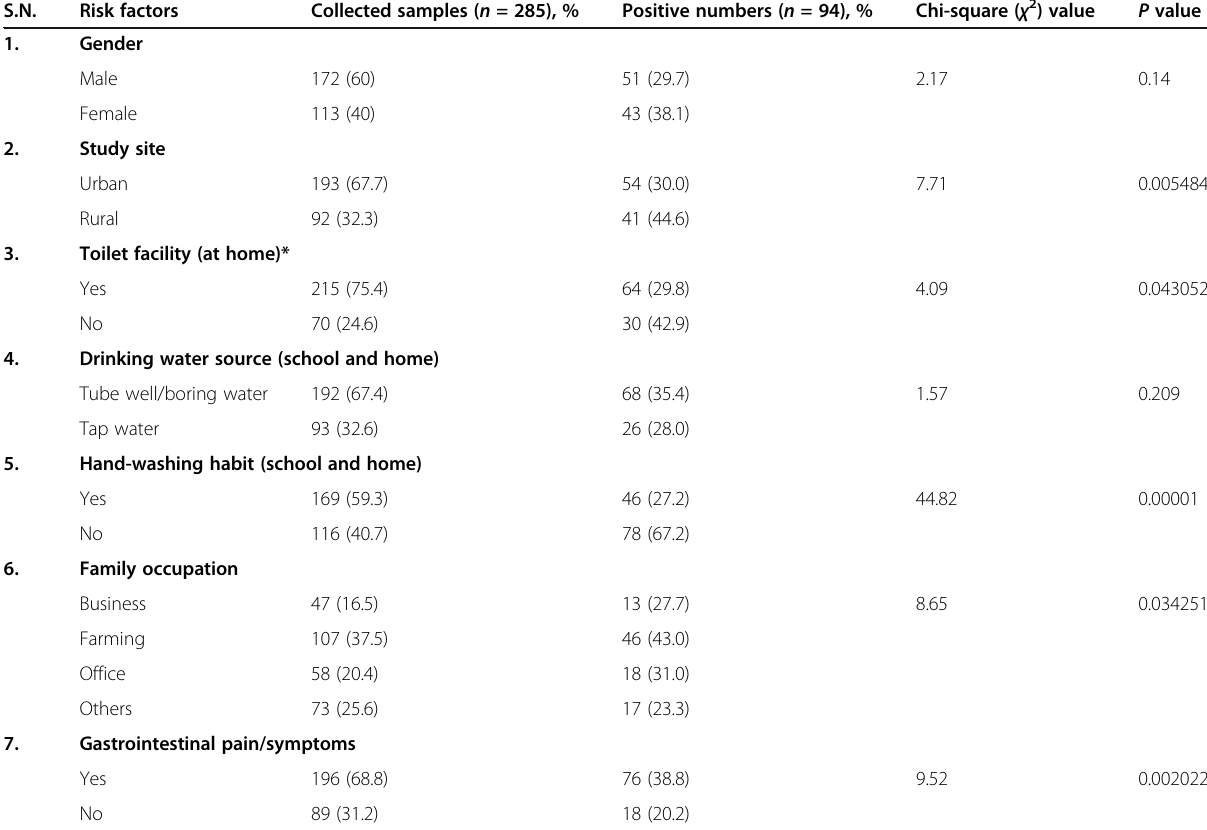
Table 3 Potential risk factors associated with the prevalence of parasites among study population